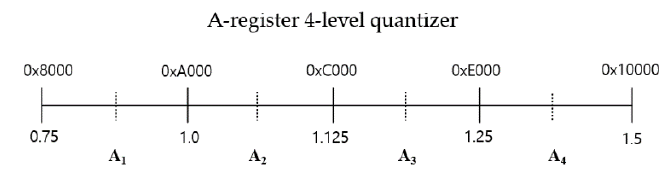
Figure 5. 4-level Quantization method.